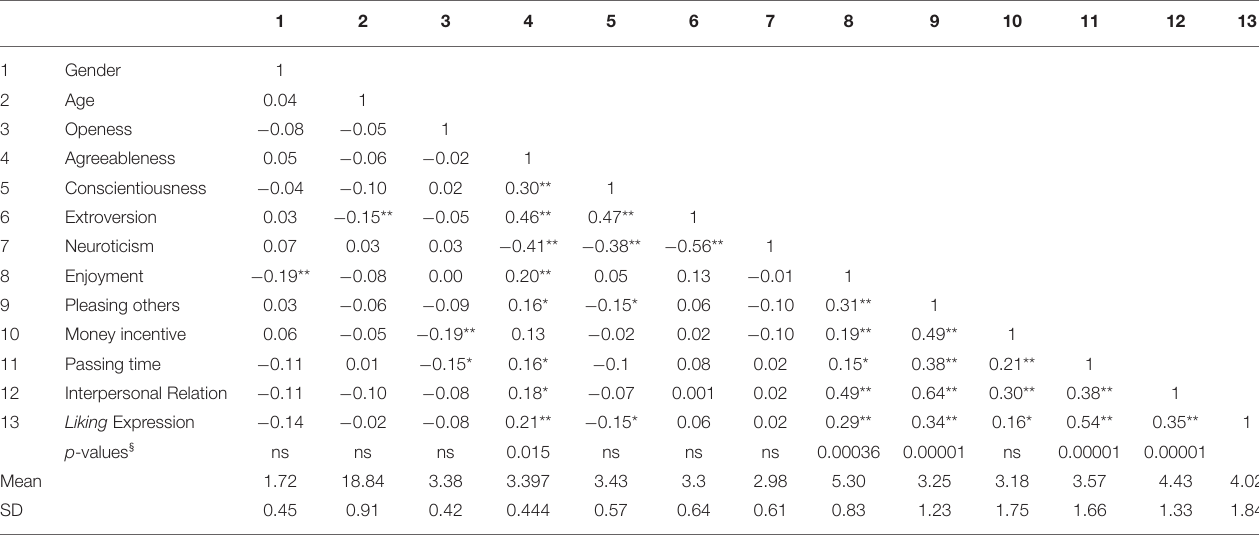
TABLE 1 | Means, standard deviations, intercorrelations between sex, age, personality traits, communication motives, and liking expression, and P -values with Benjamini–Hochberg